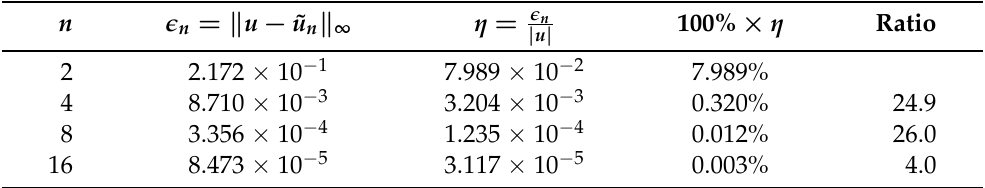
Table 6. IE (48), λ A = 50. QM: Trapezoidal rule and Taylor